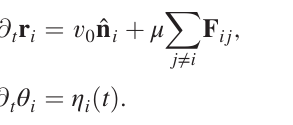
ffiffiffi p 5 . At ϕ ≈ 0 . 37 the CID drops precipitously,